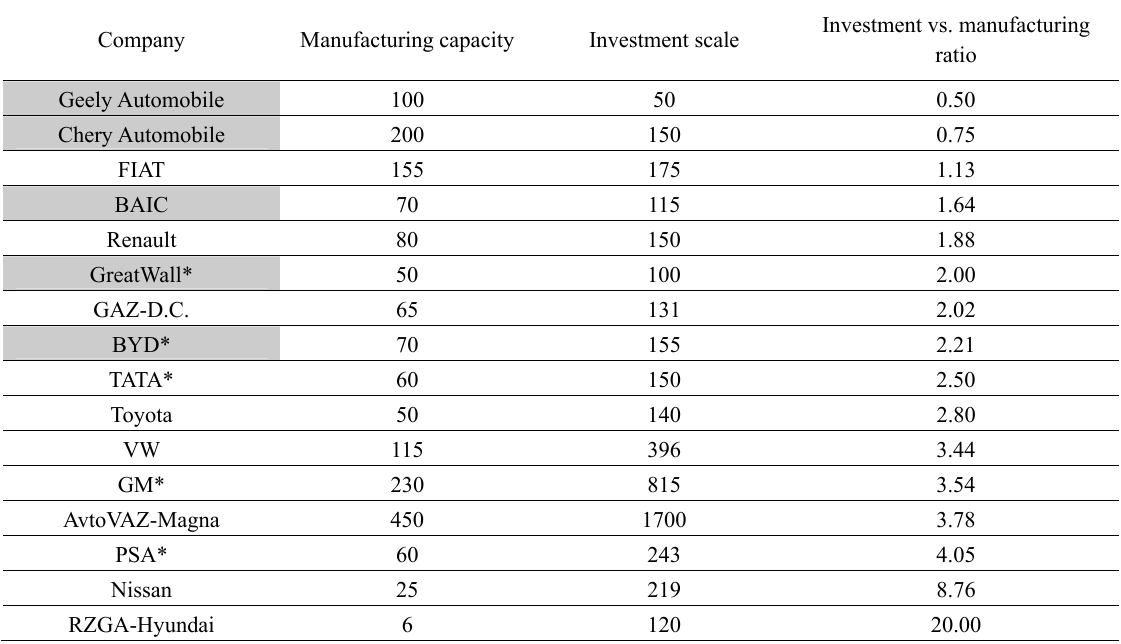
Table 6. New OEM Projects in 2006 (unit: 1,000 vehicles/$1